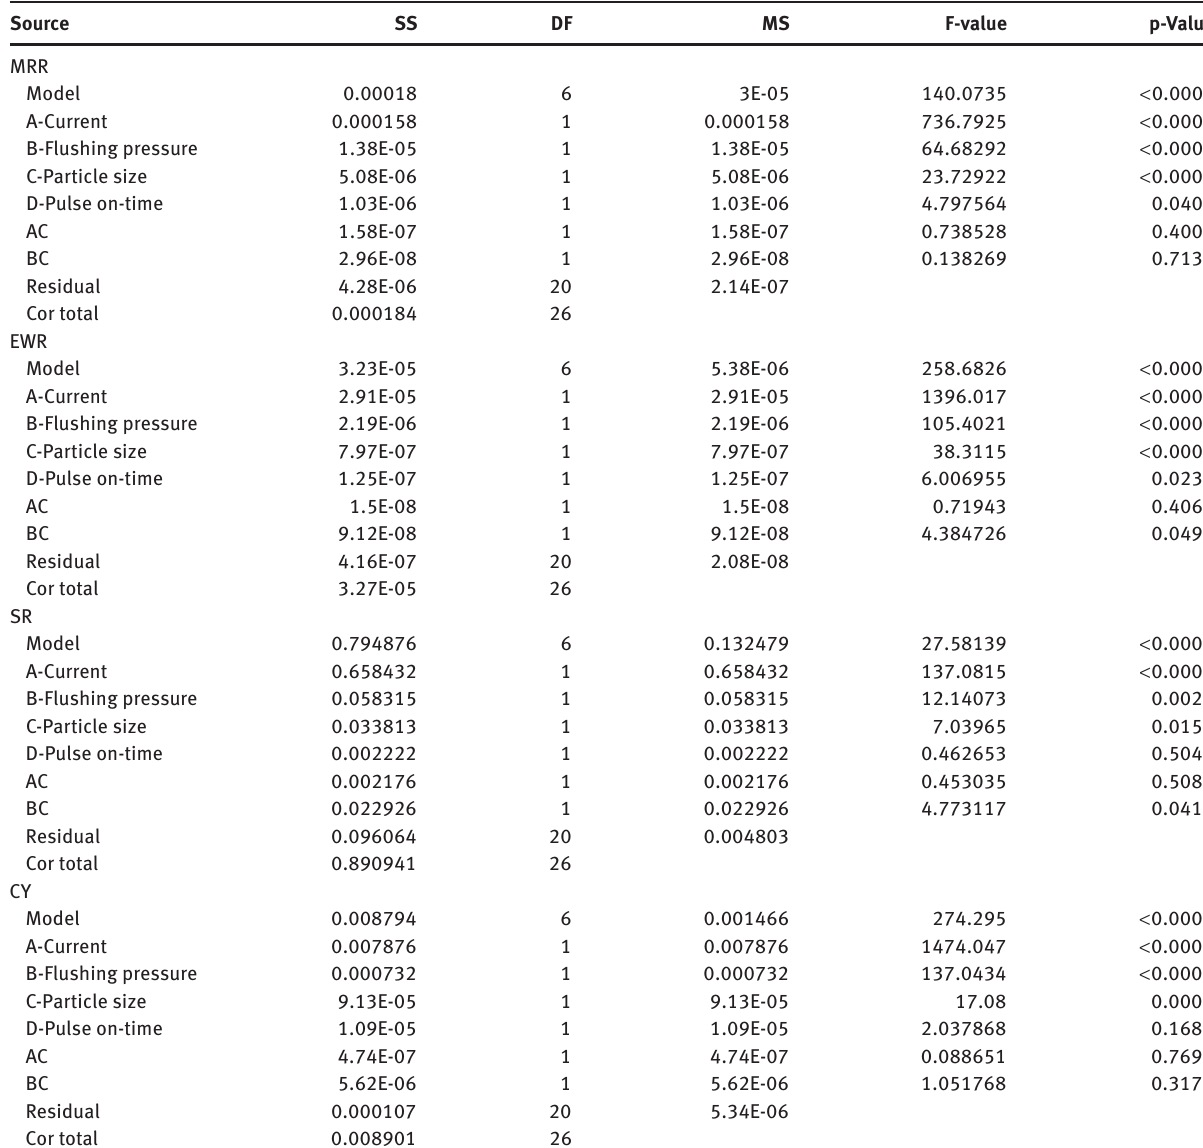
Table 4 ANOVA for MRR, EWR, SR, and